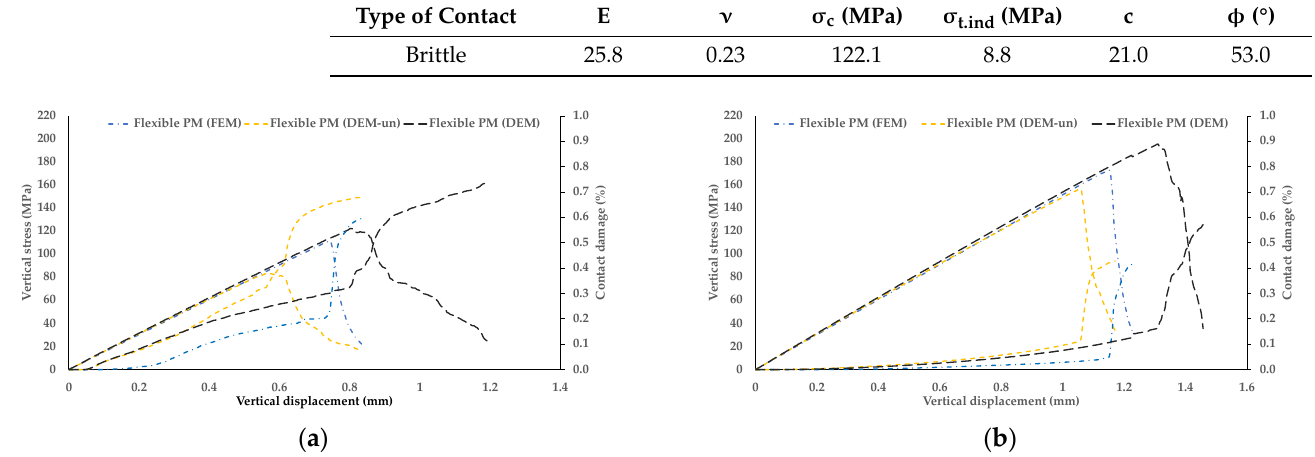
Figure 8. Axial stress–displacement response under uniaxial compression-proposed flexible PM models and DEM-inner contacts): ( a ) brittle model; ( b ) bilinear softening model.